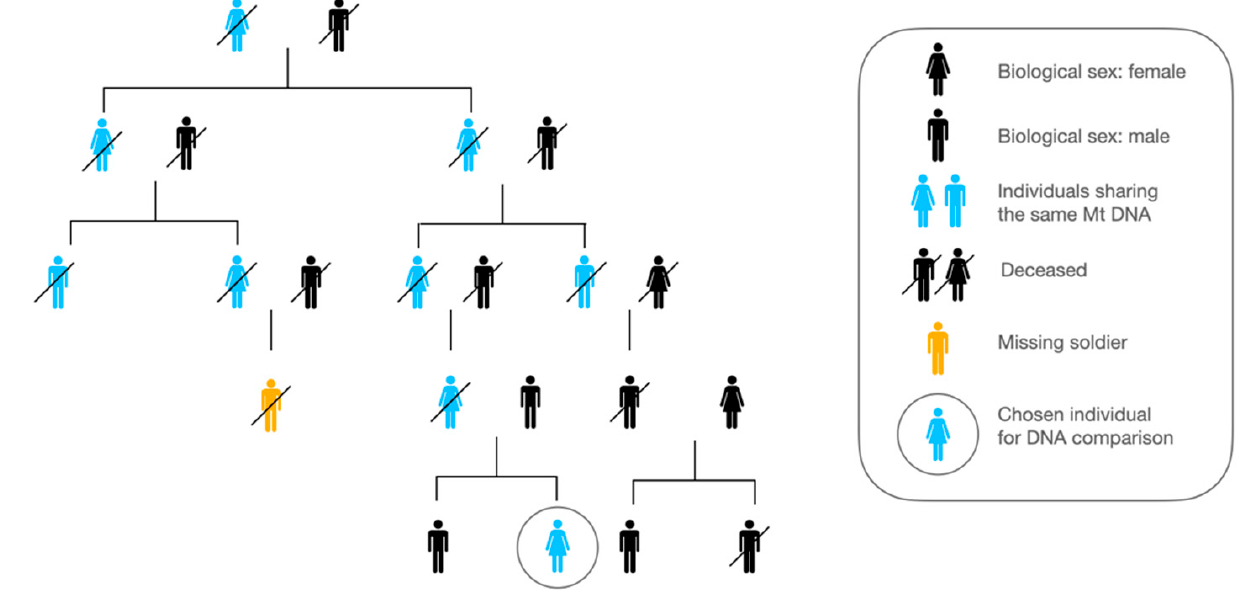
Figure 4. Example of how to choose and find the best family individual for DNA comparison. Genealogic representation.